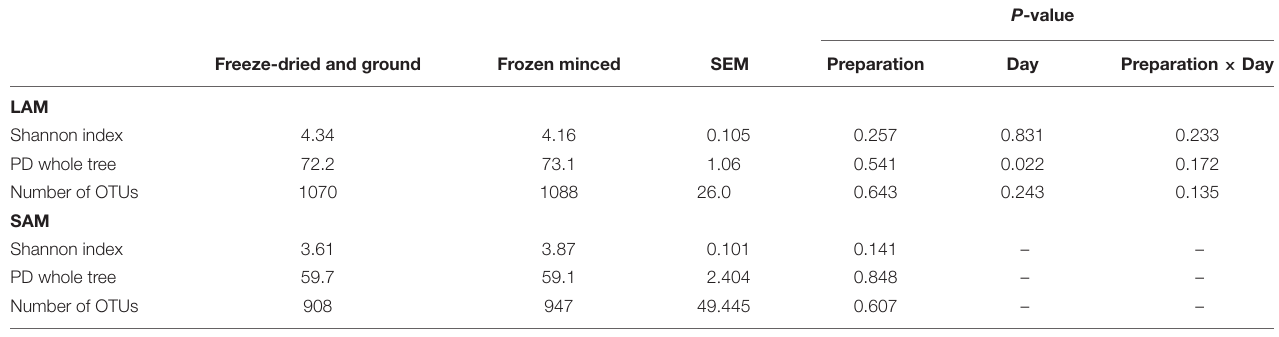
TABLE 3 | Archaeal and bacterial richness and diversity measures for liquid-associated microbes (LAM) and solid-associated microbes (SAM) samples for freeze-dried and ground and frozen minced forage types.